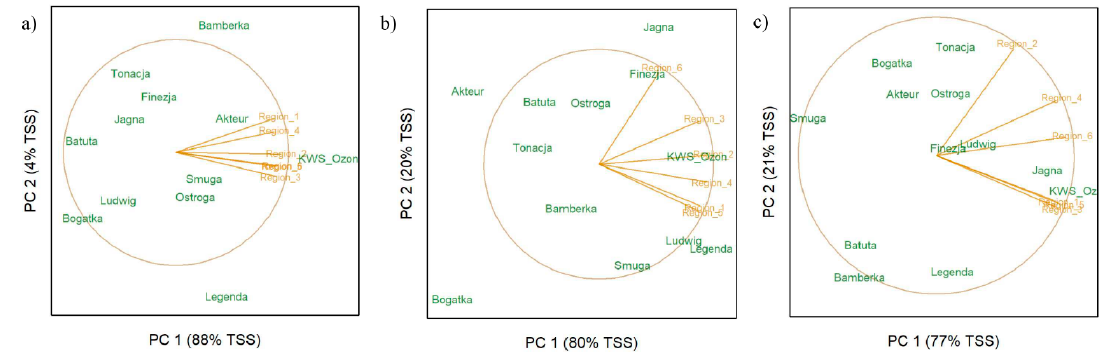
Figure 2. GGE (genotype main e ff ects plus genotype × environment interaction e ff ects) biplots based on adjusted means of cultivar × region combinations for the survey dataset ( a ), for the moderate-input crop management (MIM), multi-environmental trial dataset ( b ), and for the high-input crop management (HIM), multi-environmental trial dataset ( c ). PC, principal component; TSS, total sum of